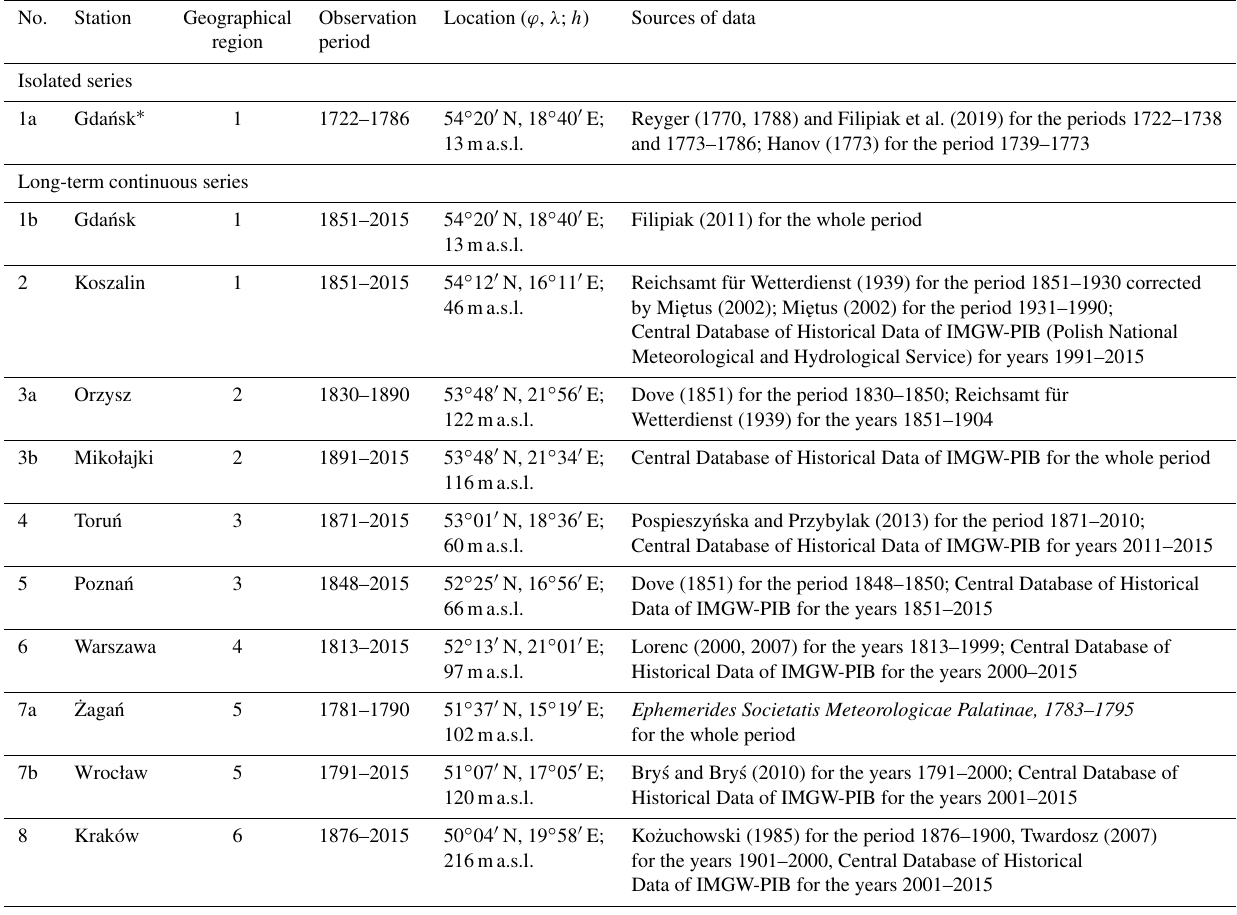
Table 2. List of sites, their locations, and periods covered by series of monthly precipitation totals used in the paper. No. Station Geographical Observation Location ( ϕ , λ ; h ) Sources of data region period Isolated